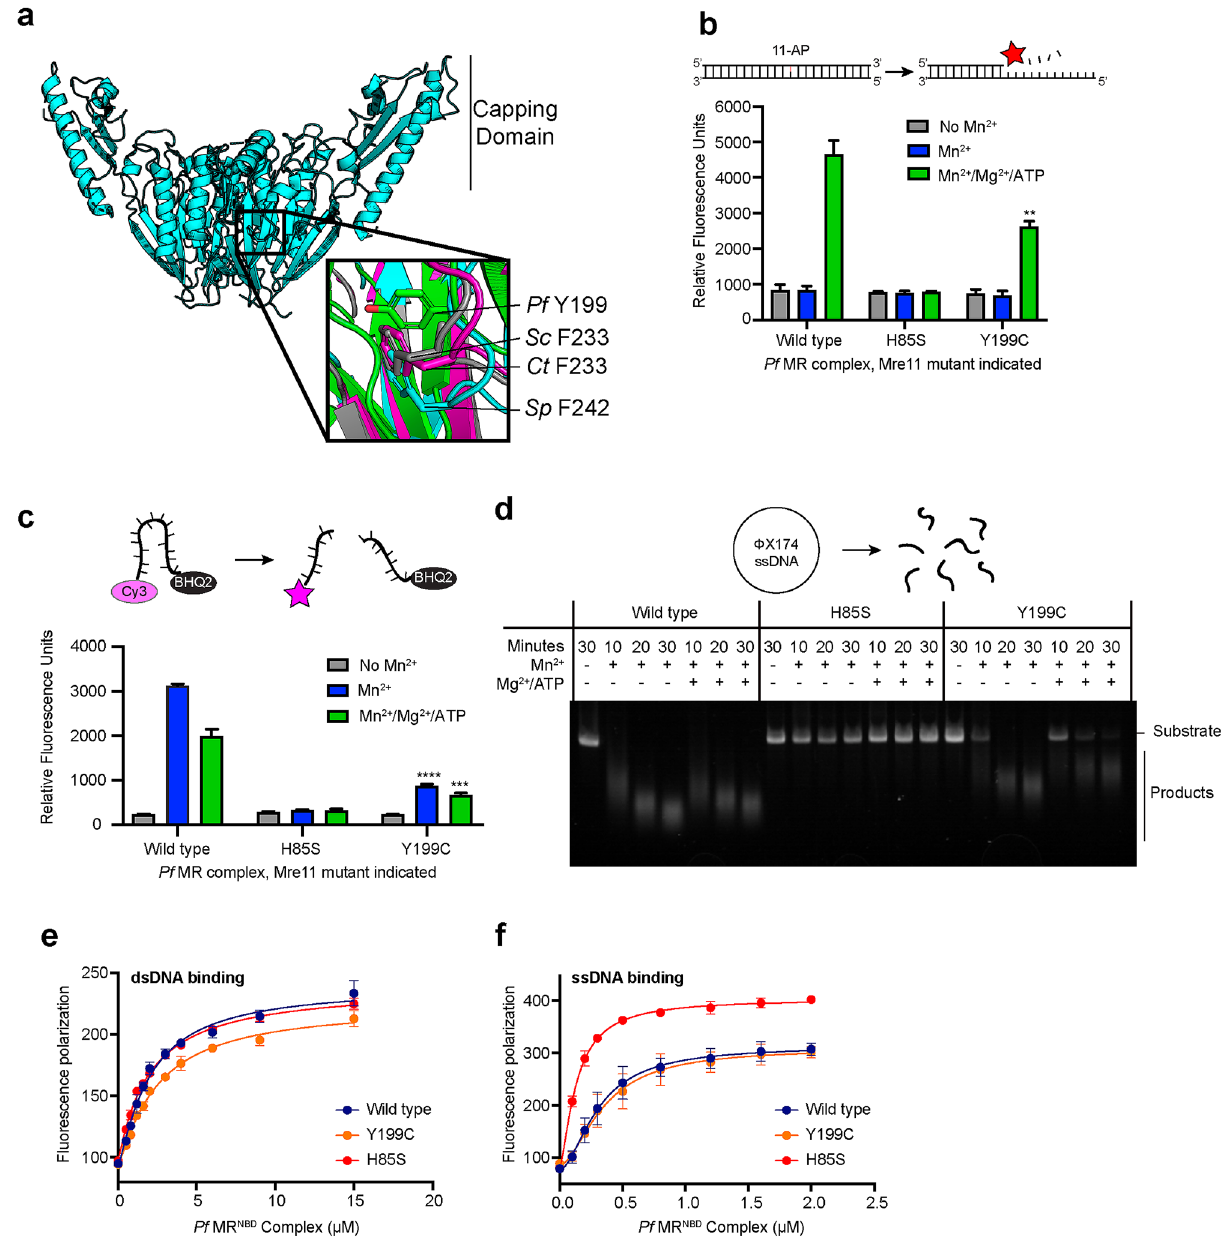
Figure 1. Pf Mre11 Y199C has deficient nuclease activity. ( a ) X-ray crystal structure of S. pombe Mre11 ND . Outset shows the superimposition of a region of the X-ray crystal structures for P. furiosus 32 , S. pombe 66 , and C. thermophilum 67 Mre11 ND shown in green (PDB ID: 1II7), cyan (4FCX), and magenta (4YKE), respectively. The S. cerevisiae structure, shown in grey, is from a homology model that was relaxed via molecular dynamics simulations 68 . Structurally similar residues to H. sapiens F237C are shown in sticks. ( b ) Grey, blue, and green bars indicate the 2-AP fluorescence resulting from MR exonuclease activity (30 min at 60 °C) in the no Mn 2+ , Mn 2+ , and Mn 2+ /Mg 2+ /ATP conditions, respectively. The two asterisks (**) denote a p-value of less than 0.01 compared to wild type activity. Schematic above illustrates the exonuclease reaction. ( c ) Quantification of endonuclease activity (30 min at 60 °C) using the Cy3/BHQ2-labeled ssDNA substrate. Colors are same as in ( b ). Three (***) and four (****) asterisks denote a p value of less than 0.001 and 0.0001, respectively. Schematic above illustrates the endonuclease reaction. ( d ) Agarose gel showing the endonucleolytic degradation of a ΦX174 single stranded virion circular DNA after incubation with MR complexes at 60 °C in Mn 2+ or Mn 2+ / Mg 2+ /ATP for the indicated amount of time. Mn 2+ was omitted as a negative control. Schematic above illustrates the plasmid-based endonuclease reaction. ( e and f ) Plots of the fluorescence polarization of a labeled ( e ) dsDNA or ( f ) ssDNA substrate versus wild type (blue), Y199C (orange), and H85S (red) Pf MR NBD concentration. The solid line is the fit to the data as described in the Material and Methods, whereas the points and error bars are the average and standard deviation of three